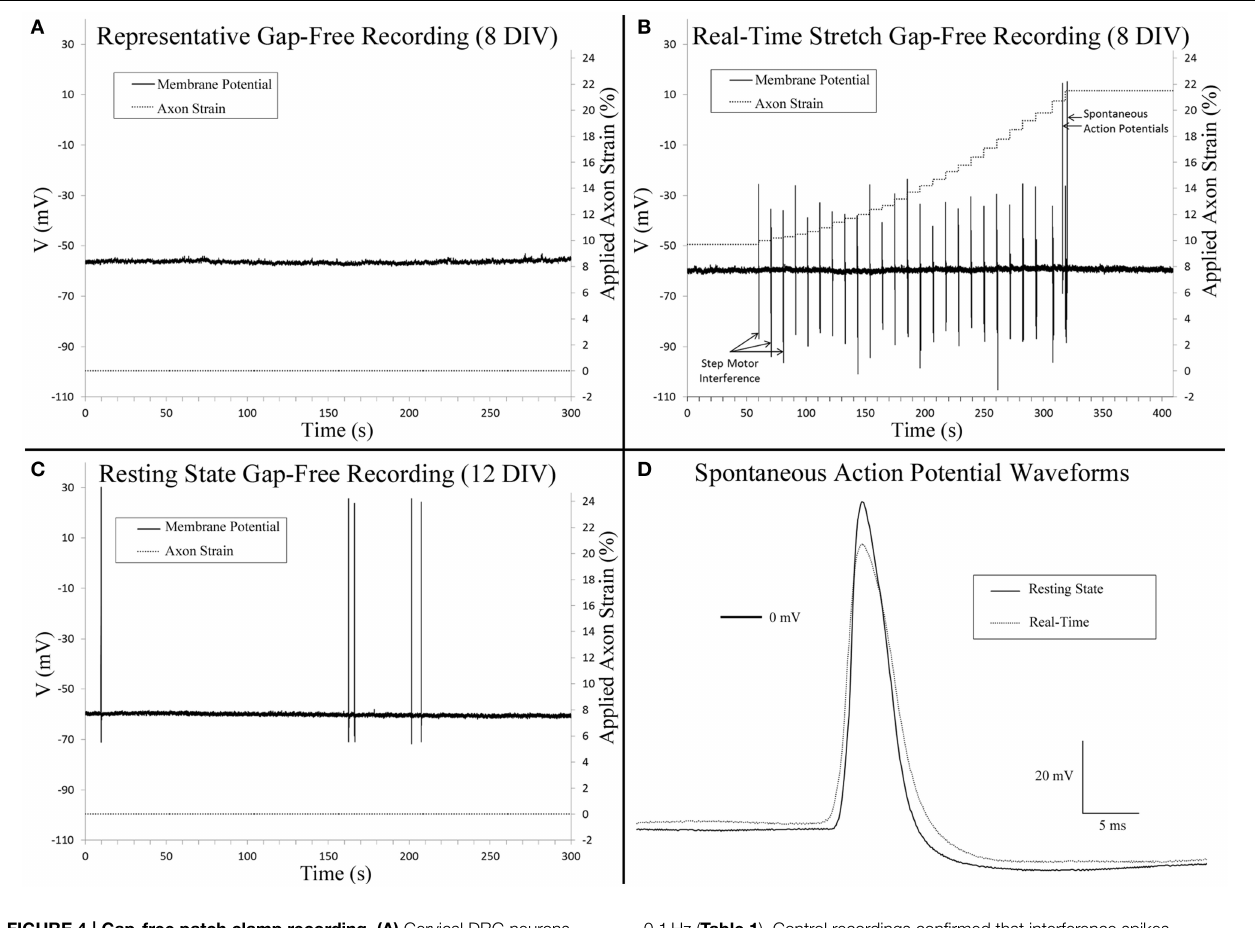
0.1Hz ( Table 1 ). Control recordings confirmed that interference spikes originated from the stepper motor and not cells. (C) A single cell at rest fired five spontaneous action potentials. (D) A comparison of spontaneous action potentials obtained from (B,C) revealed that peak voltage was reduced by 11.6mV in the cell undergoing real-time